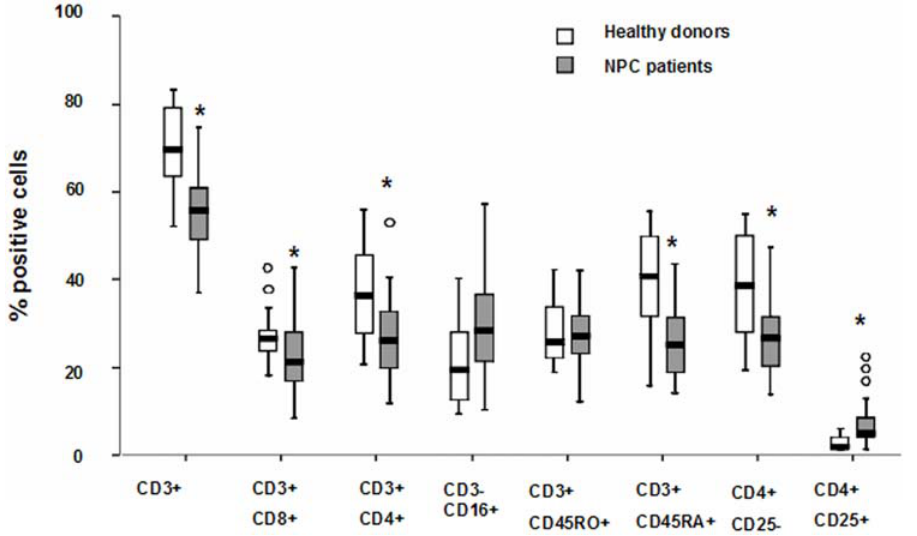
Figure 2. Immunophenotype of PBMCs from healthy donors and NPC patients. Surface markers analysis was performed by directly immunofluorescence labeling and FACS analysis in PBMCs from healthy donors (n=20) and NPC patients (n=40). * P ,